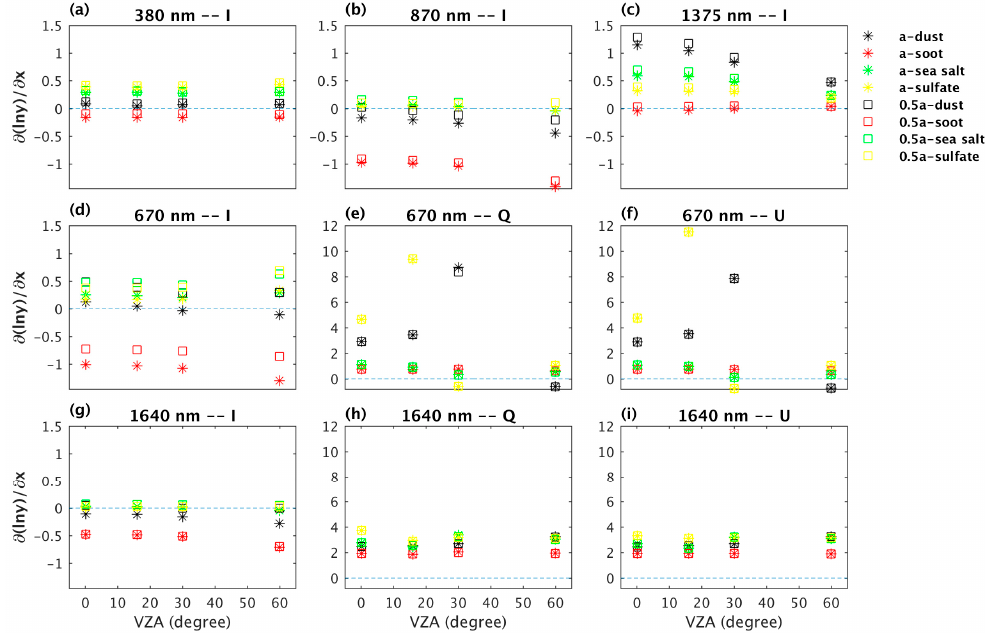
Figure 1. Jacobians of AOD in all channels of CAPI at four viewing angles (0 ◦ , 16 ◦ , 30 ◦ , 60 ◦ ) and 20 ◦ solar zenith angle (SZA) with a bright and a dark surface for four types of aerosols. ( a – c ) represent Jacobians at 380 nm, 870 nm and 1375 nm, respectively. ( d – f ) and ( g – i ) are polarized Jacobians of Stokes vector I, Q and U at 670 nm and 1640 nm, respectively. The black, red, green and blue markers mean radiance or polarization for dust, soot, sea salt and sulfate, respectively. The asterisks represent the bright surface with albedo α ( λ ), and squares mean the dark surface with 0.5 × α ( λ ) as albedo. The thin blue dashed line represents zero Jacobian.